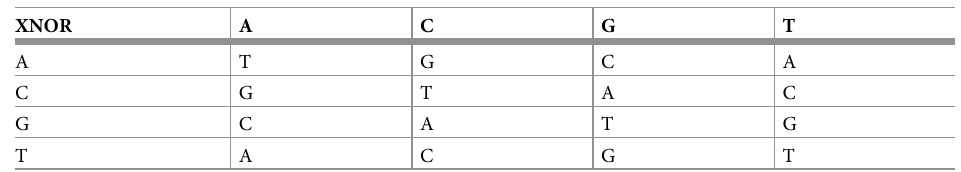
Table 6. DNA XNOR.